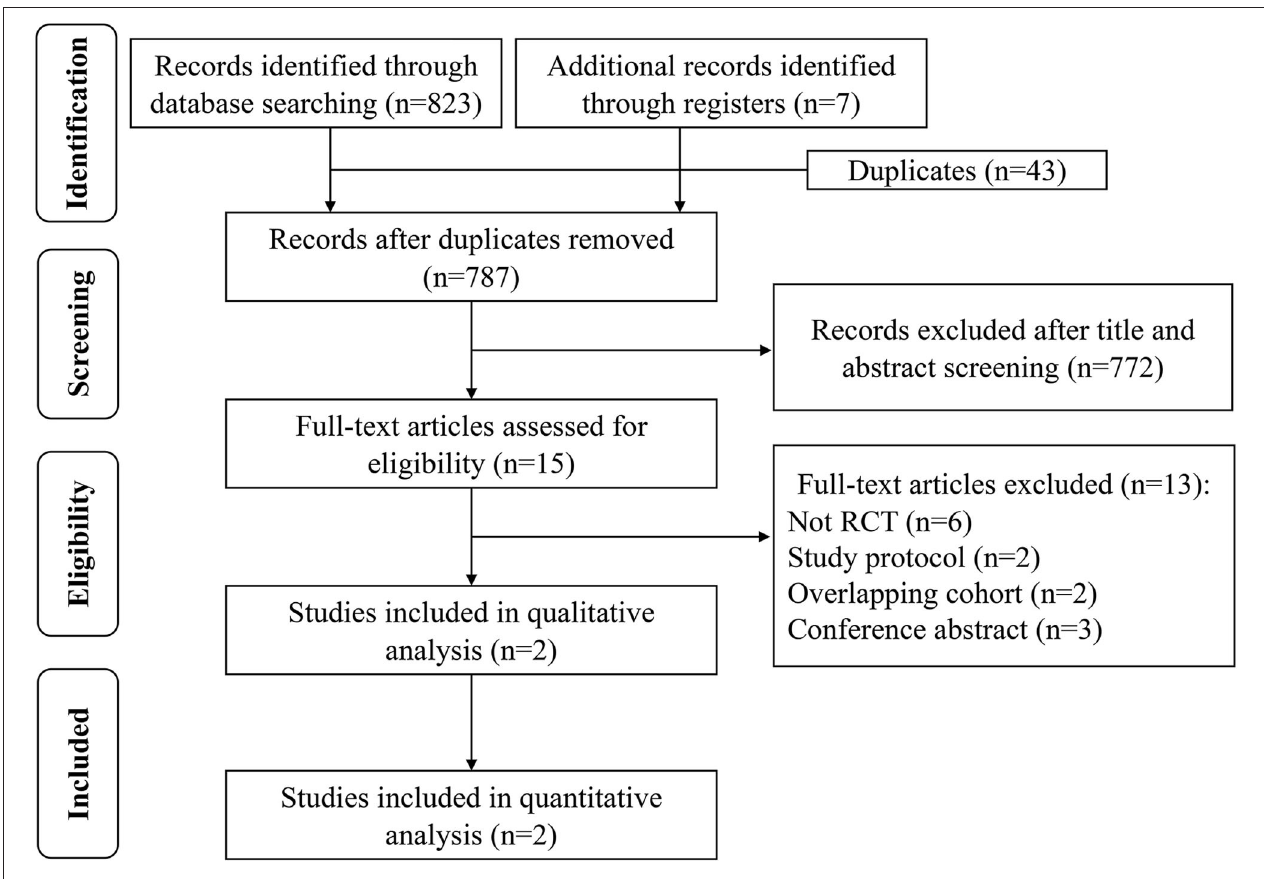
FIGURE 1 | Flow diagram of literature for the